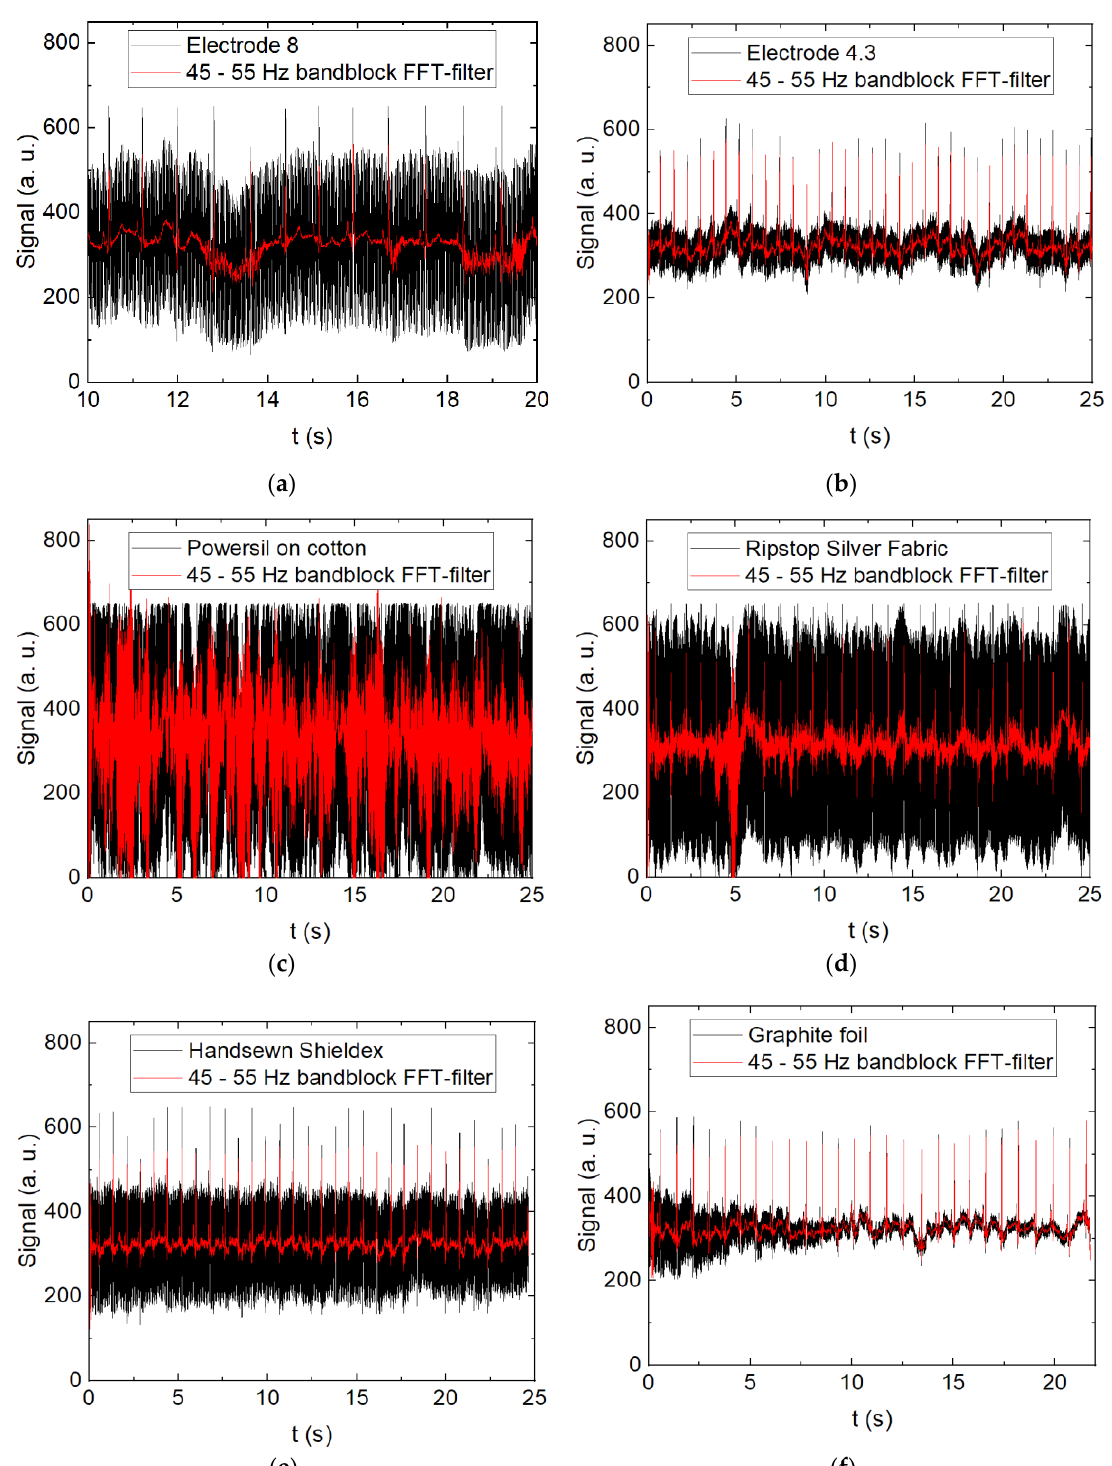
Figure 6. ECG measurement with textile electrodes with the laptop attached to the power grid: ( a ) electrode 8; ( b ) electrode 4.3; ( c ) Powersil on cotton; ( d ) Ripstop Silver Fabric; ( e ) handsewn Shieldex yarn; ( f ) non-textile graphite foil.